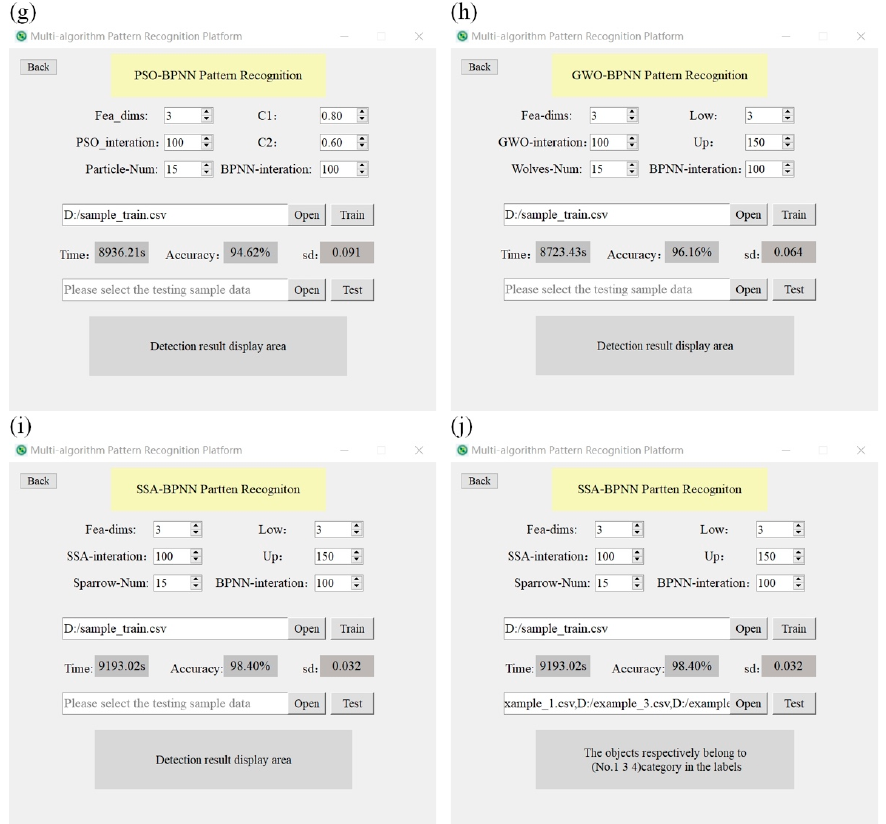
Figure 6. Multi-algorithm pattern recognition model platform. ( a ) Main interface of multi-algorithm pattern recognition platform. ( b ) KNN pattern recognition interface. ( c ) CNN pattern recognition interface. ( d ) SVM pattern recognition interface. ( e ) RF pattern recognition model interface. ( f ) BPNN pattern recognition model interface. ( g ) PSO-BPNN pattern recognition interface. ( h ) GWO-BPNN pattern recognition interface. ( i ) SSA-BPNN pattern recognition interface. ( j ) SSA-BPNN de-